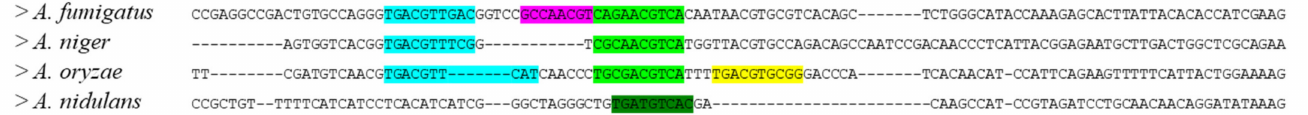
Figure 7. Evolutionary conserved putative AtfA binding site in the promoters of the catA ortholog genes. Promoter regions were aligned with the MAFFT software (http://www.ebi.ac.uk/To ols/msa/mafft, accessed on 2 July 2021). Blue, purple, light green, and yellow highlight putative binding sites characterized with less than 5% maximum matrix dissimilarity rate (Promo tool). The dark green color highlights a putative AtfA binding site of A. nidulans